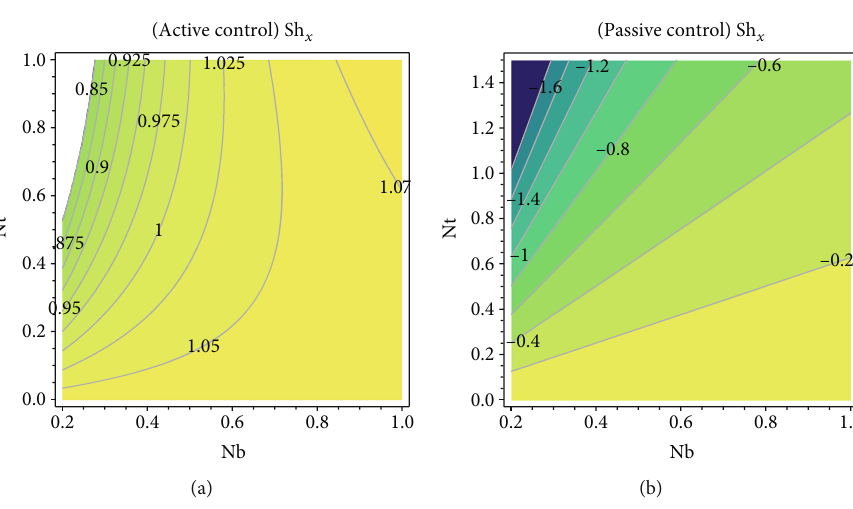
Figure 9: The e ff ect of Sherwood number for combined parameters Ntand Nb .